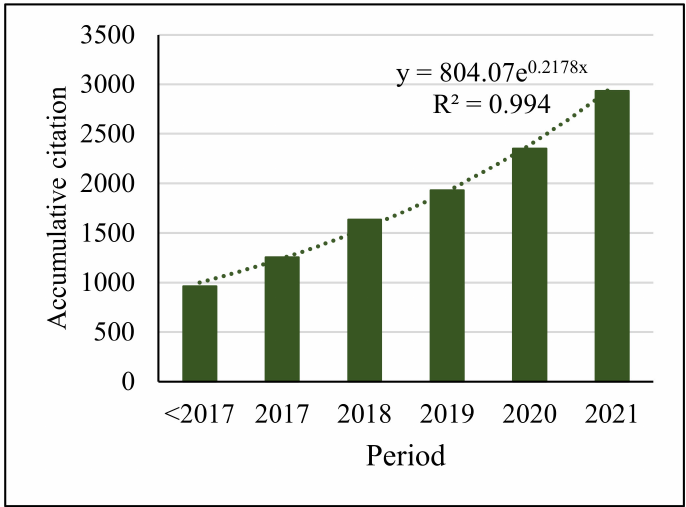
Figure 10. Evolution of citations of published works on